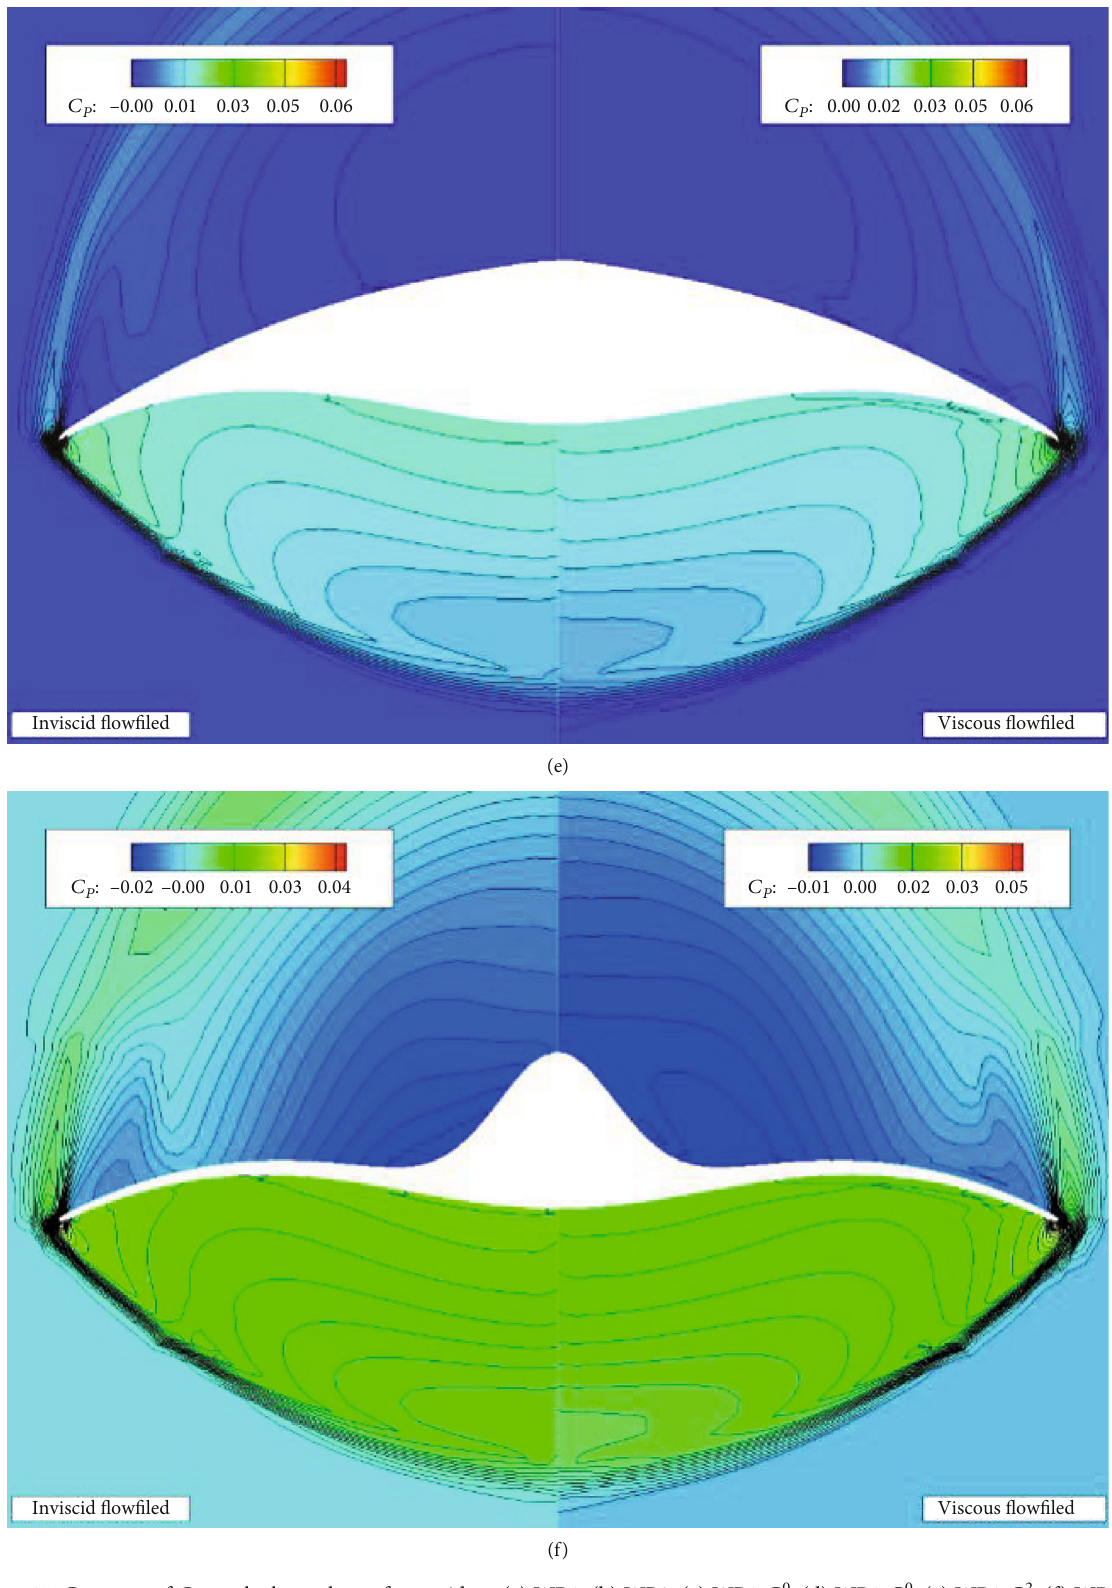
Figure 17: Contours of C on the base plane of waveriders: (a) WR1; (b) WR2; (c) WR1-G 0 ; (d) WR1-G 0 ; (e) WR1-G 2 ; (f) WR2-G 2 P